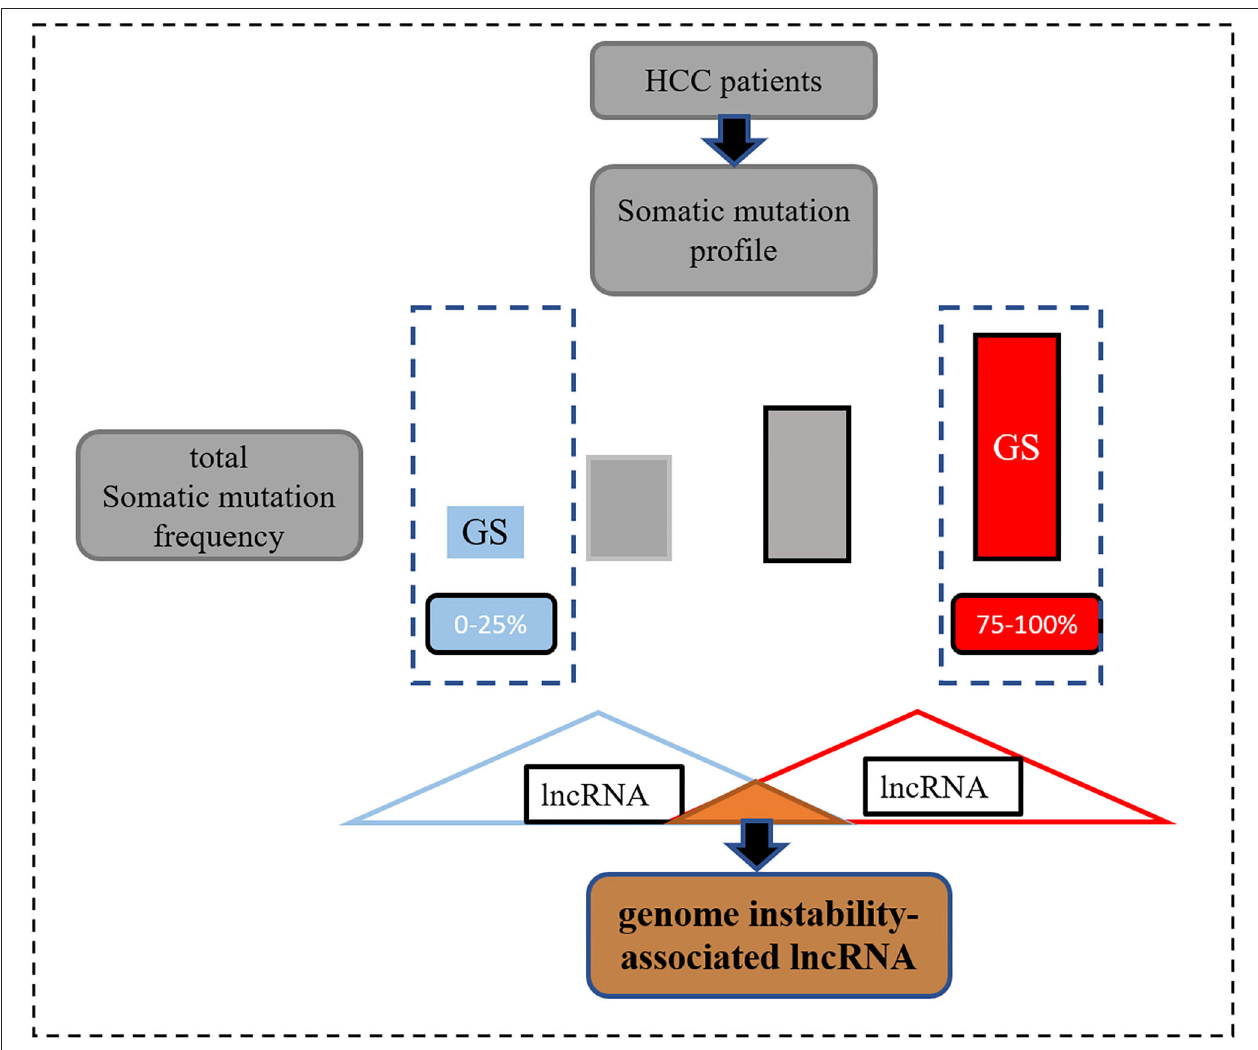
FIGURE 1 | The process of screening genomic instability-associated